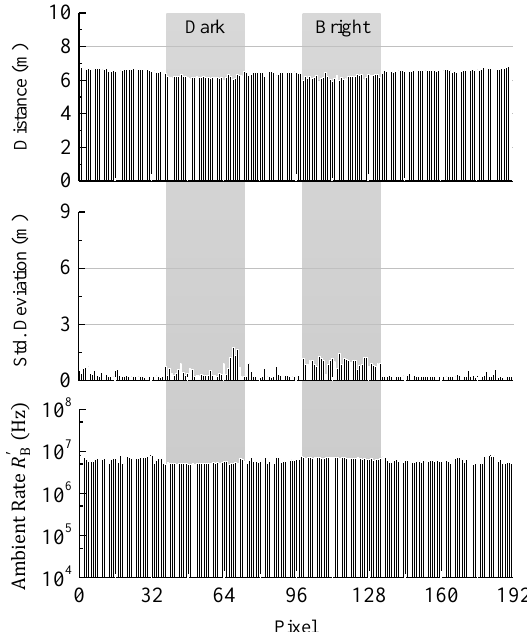
Figure 13. Mean distance, standard deviation, and ambient event rate after applying pixel-wise adaptive coincidence parameter adjustment. This allows a measurement of dark and bright targets in the same scene at once. The ambient event rates are kept at an almost constant level for all pixels.